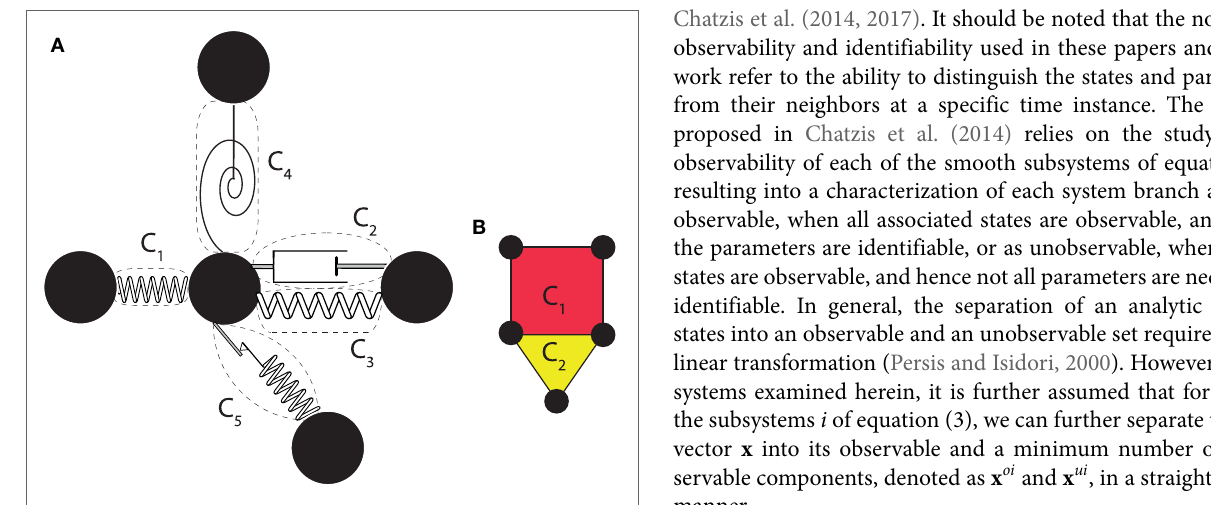
FIGURE 1 | Systems described as nodal points connected with components (A) Discrete masses connected with components providing resistance to motion (B) nodes connected with finite